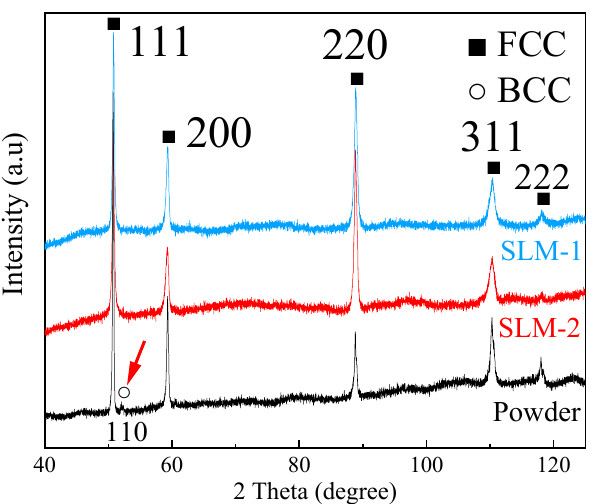
Figure 2. XRD patterns of CrFeNiMn powder and SLM CrFeNiMn alloy.